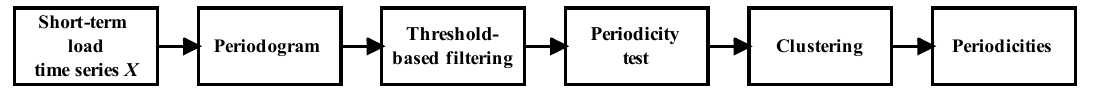
Figure 2. Flowchart for recognizing the multiple periodicities.